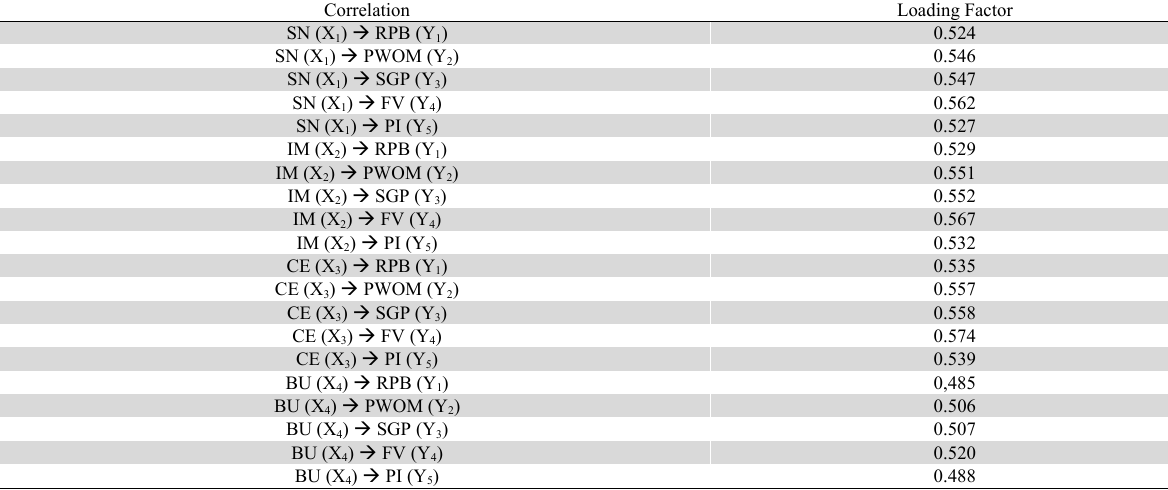
Implied Correlation of all variables